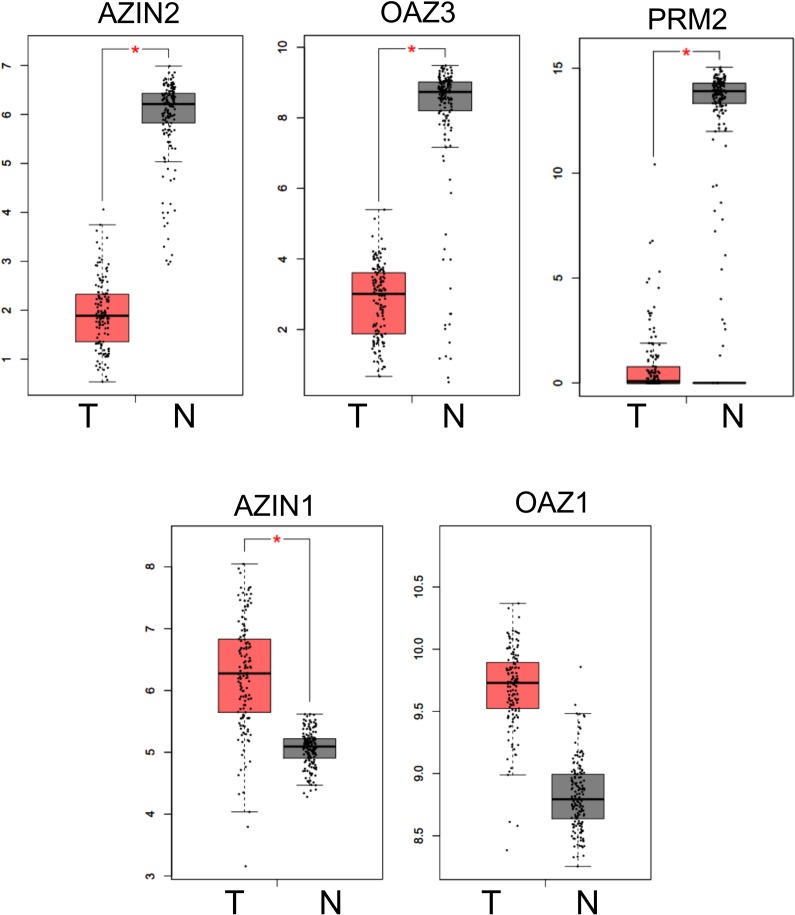
Boxplots comparing the expression of AZIN2, OAZ3 and paralogues between human testicular germ cell tumors (T) and normal testes (N).Data were obtained from the analysis of current database using Gene Expression Profiling Interactive Analysis (GEPIA; http://gepia.cancer-pku.cn/) [45]. PRM2: protamine 2. Number of samples analyzed in each group: N = 165; T = 137. * P<0.05.